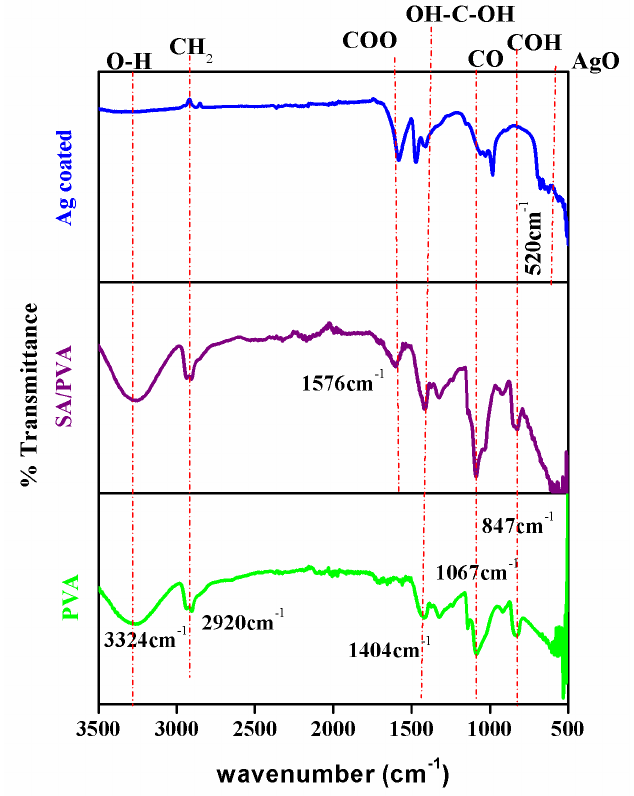
Figure 5. FTIR analysis of PVA, SA/PVA, Ag coated